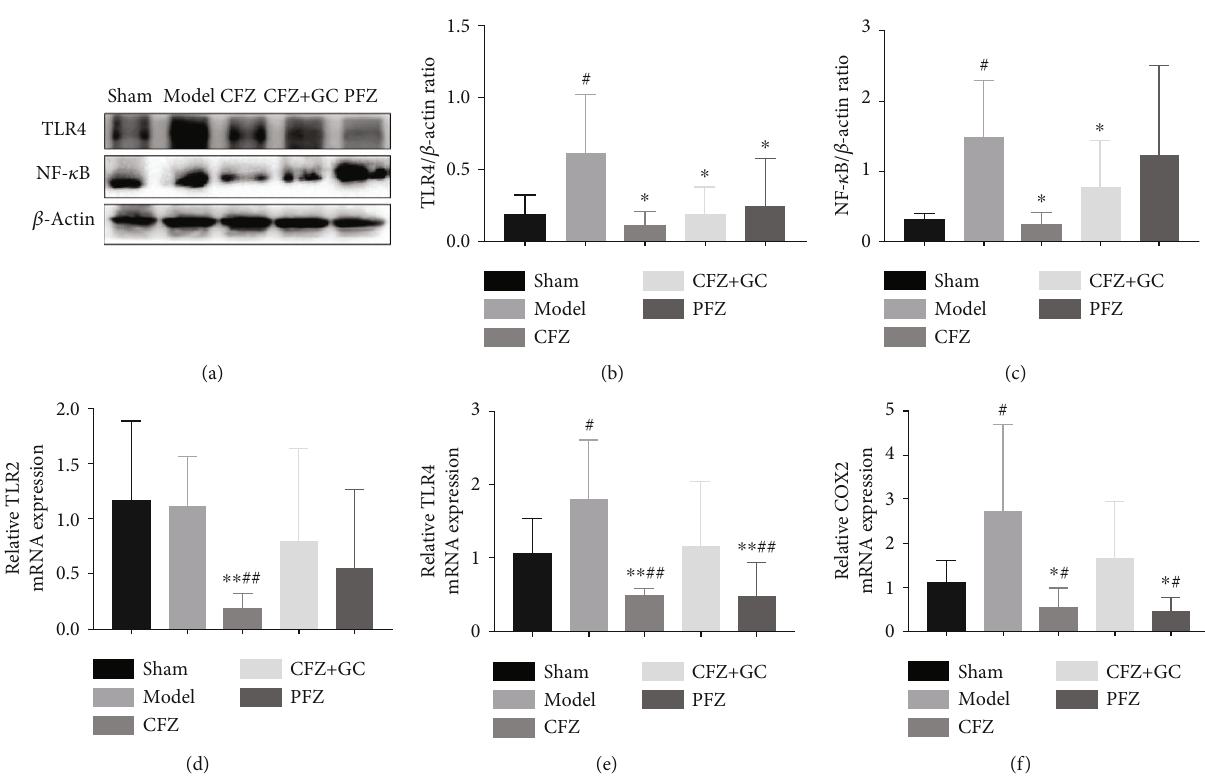
Figure 8: Toll-like receptor-4 (TLR4)/nuclear factor kappa beta (NF- κ B) pathway detection in the heart among mice in all groups. (a) Representative images for TLR4 and NF- κ B protein detection by western blotting. (b – c) TLR4 and NF- κ B protein expression in the heart of mice, respectively. (d – f) mRNA expression of TLR2, TLR4, and cyclooxygenase-2 (COX2) in the heart of mice, respectively. # P < 0 : 05 and ## P < 0 : 01 versus the sham group; ∗ P < 0 : 05 and ∗∗ P < 0 : 01 versus the model group.